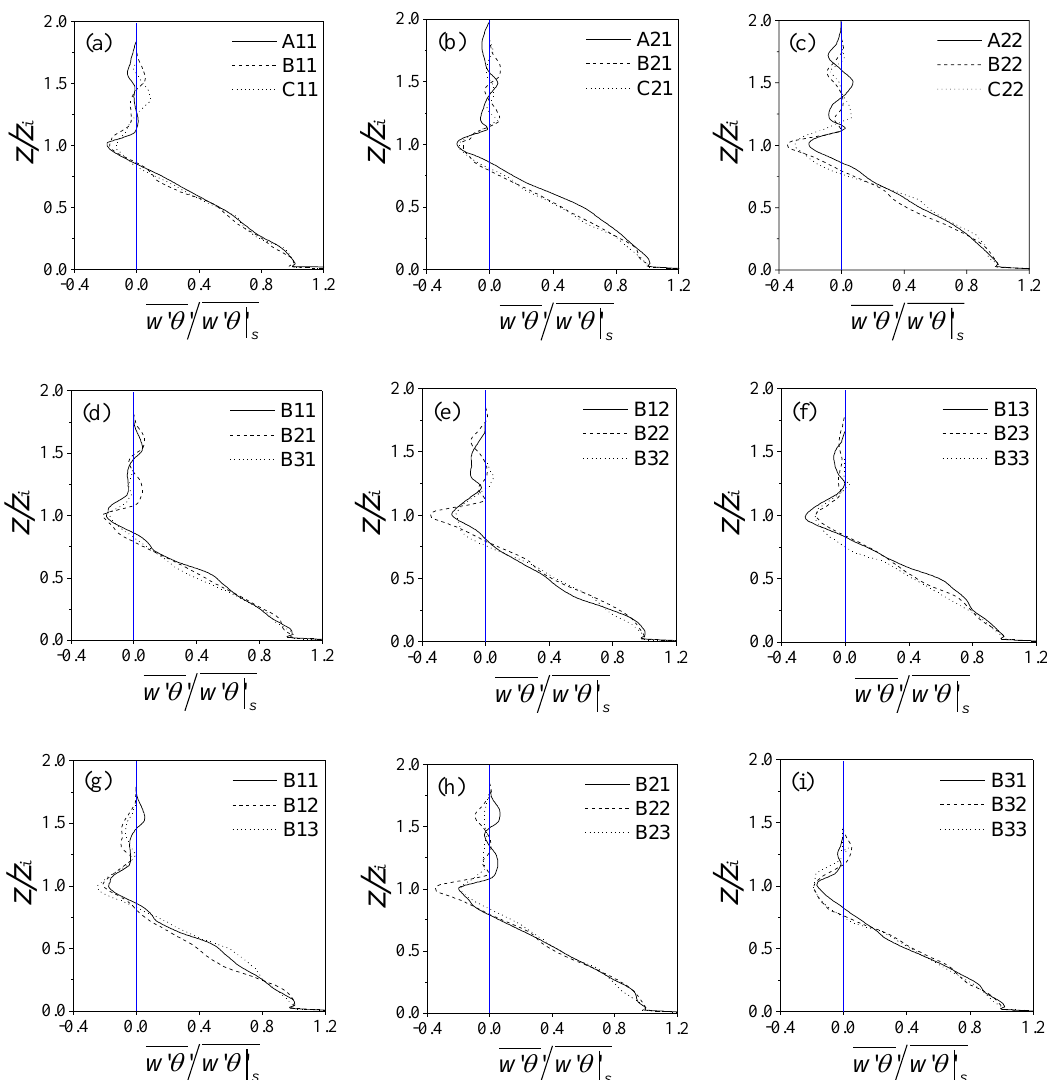
Figure 2. Evolution of the buoyancy flux profiles for the simulated cases in Table 1. The buoyancy flux is normalized by w (cid:48) θ (cid:48) , and the height of CBL is normalized by z i . ( a – i ) respectively correspond to the evolution of the normalized thickness of the entrainment layer in cases when only one boundary condition ( ∆ U , Γ θ and w (cid:48) θ (cid:48) ) is changed. The case names in the figure refer to Table 1.